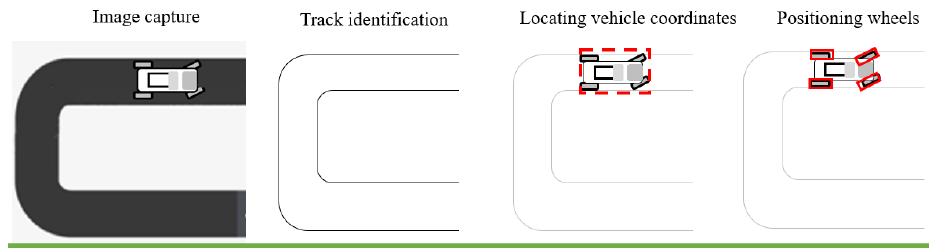
Figure 5. Schematic diagram of processing method for vehicle off-track detection.